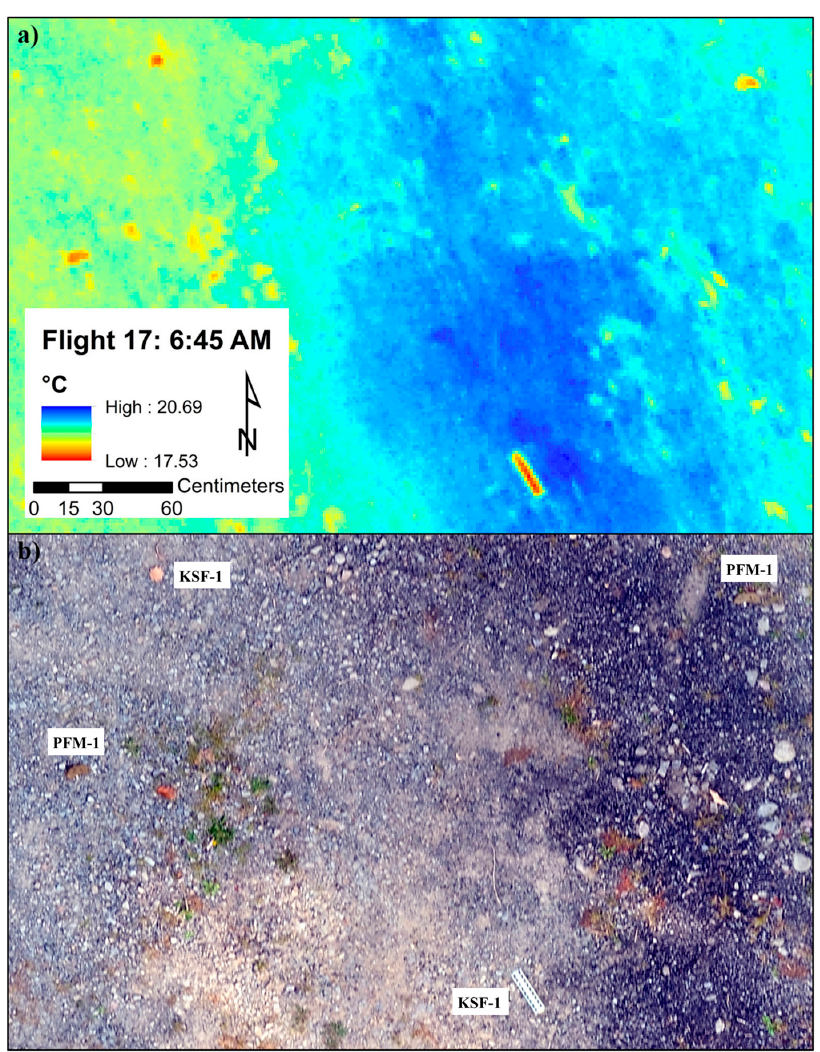
Figure 6. ( a ) Apparent temperature at 6:45 A.M. flight around sunrise, and ( b ) aerial photogrammetry over the same area.